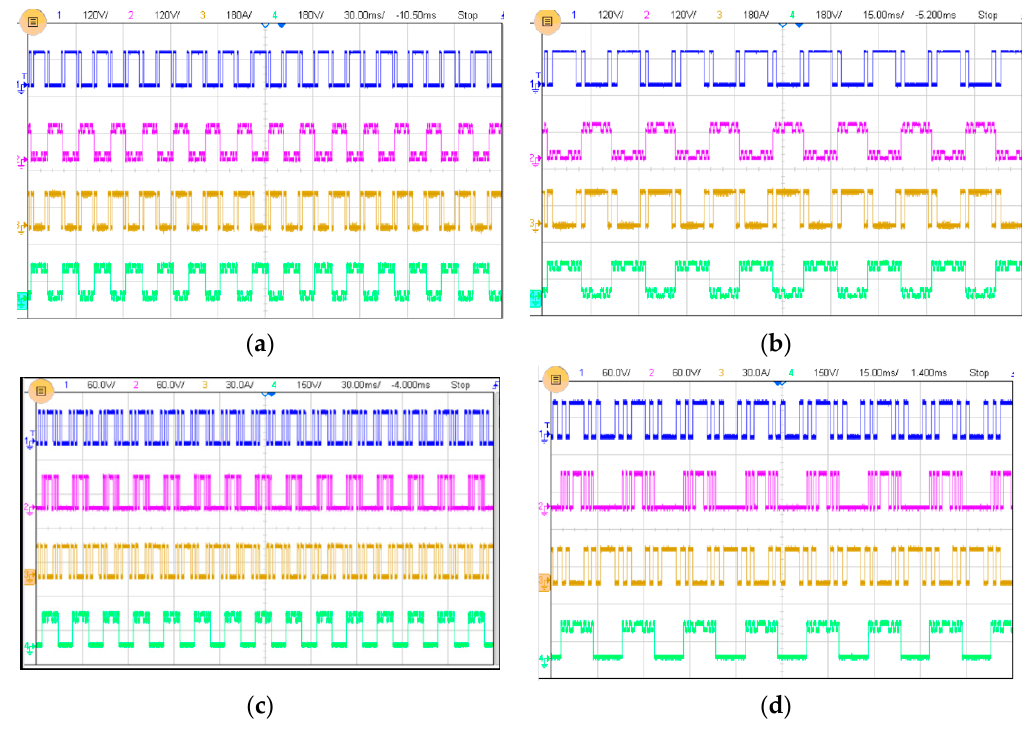
Figure 14. Experimental results of 13-level inverter voltage and current for continuous load changes.